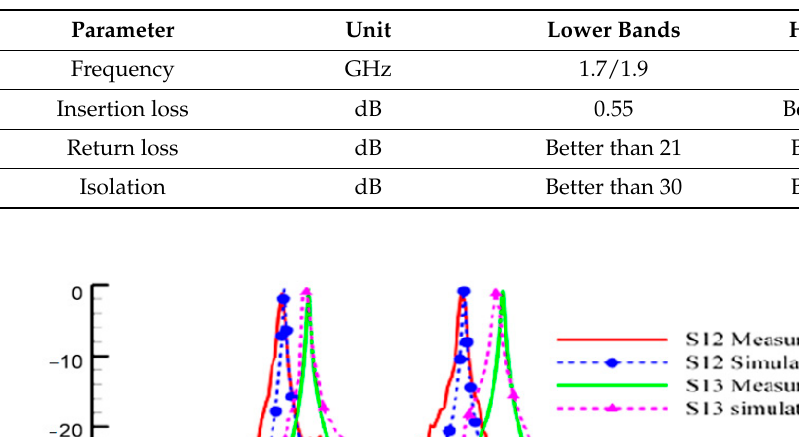
Table 1. Specifications of the proposed diplexer.